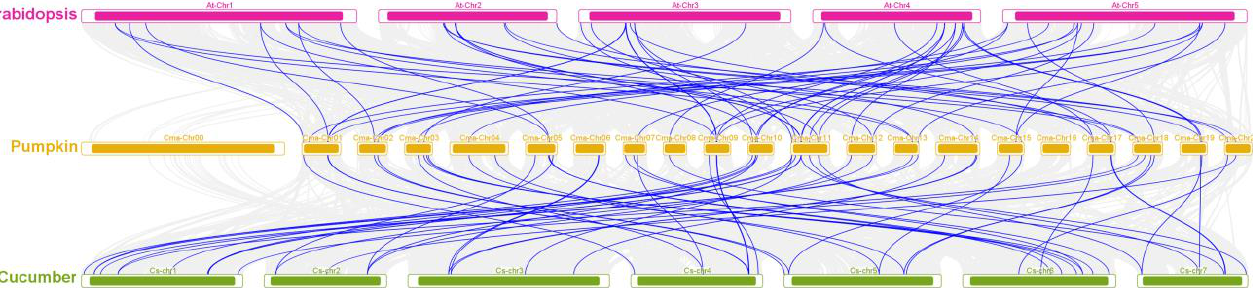
Figure 4. Synteny analysis of C. maxima WD40 genes between A. thaliana and C. sativus . The grey lines in the background indicate the collinear blocks between C. maxima and other plant genomes, while the blue lines highlight the syntenic WD40 gene pairs. The chromosome number is indicated at the top of every